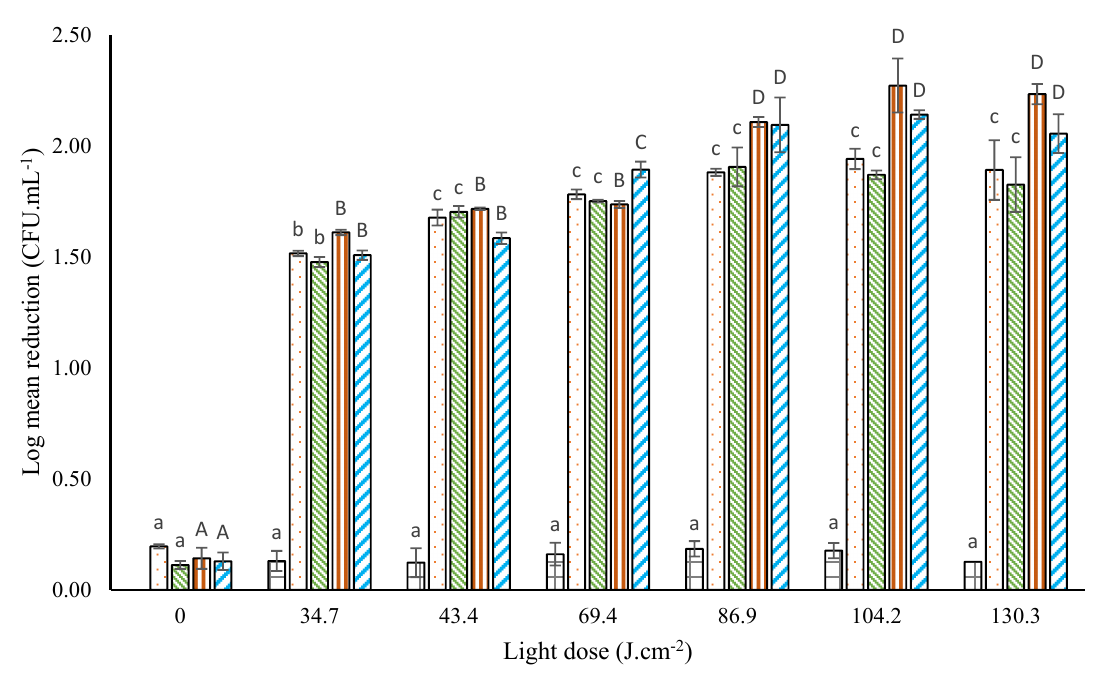
Figure 2. Effect of curcumin-based photosensitization at different curcumin concentrations, prepared in ethanol and propylene glycol, and light doses on reduction of Aspergillus flavus spores in vitro. Data are means ± SE ( n = 9); means with different lowercase letters indicate significant ( p < 0.05) differences at different light doses and means with uppercase letters indicate significant ( p < 0.05) differences at the same light dose.